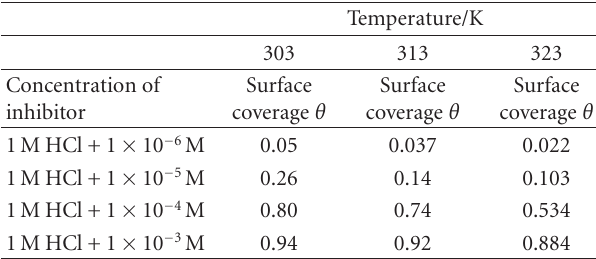
Table 3: E ff ect of concentration of trans-4-hydroxy-4 (cid:2) -stilbazole on surface coverage for mild steel in 1M HCl at various temperatures.